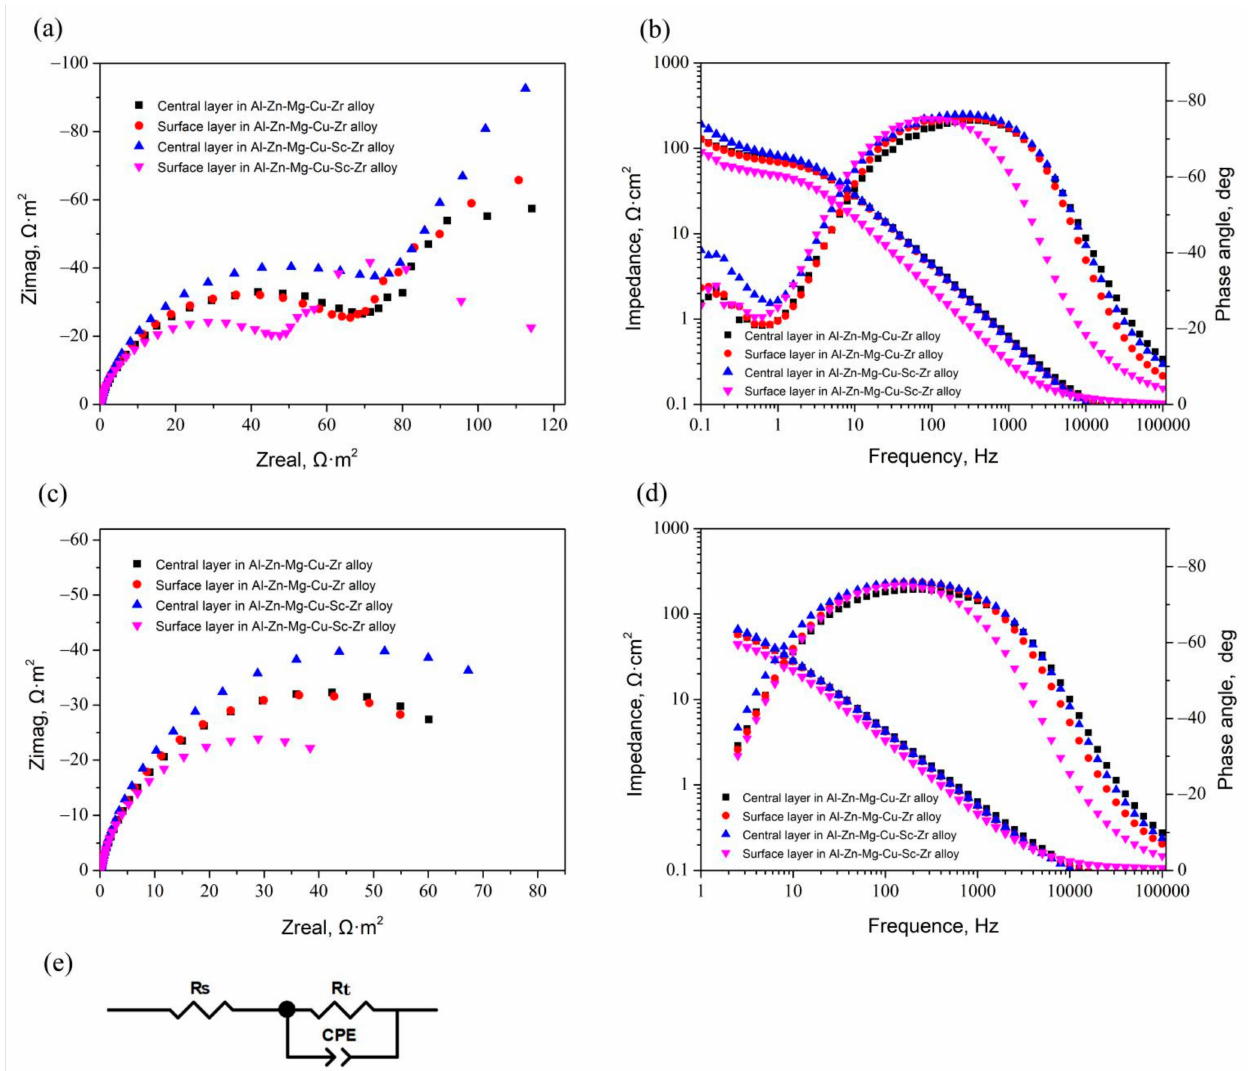
Figure 11. EIS spectra of the central and surface layer samples of Al-Zn-Mg-Cu alloys in the natural aging condition. ( a ) Measured Nyquist plots, ( b ) measured Bode plots, ( c ) fitted Nyquist plots in the high-frequency range, ( d ) fitted Bode plots in the high-frequency range, ( e ) the equivalent circuit